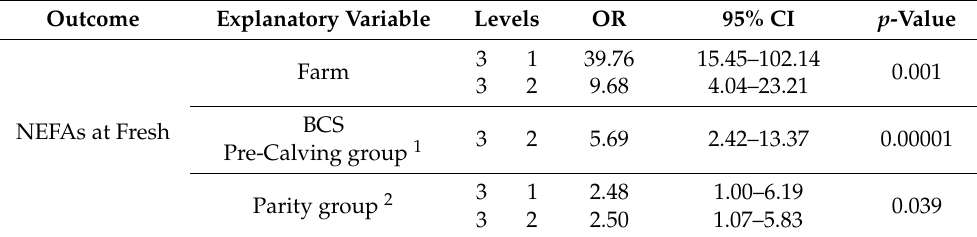
Table 4. Results from a logistic regression model with NEFAs at fresh (binary, 0.82 mmol/l threshold) as an outcome. Presented odds ratios (OR) are for odds of having a NEFAs measurement higher than 0.82 mmol/l when comparing the level on the left of the pertinent column to the level on the right. p -Values and 95% confidence intervals (CI) for calculated odds ratios are Wald based estimates. Outcome Explanatory Variable Levels OR 95% CI p -Value